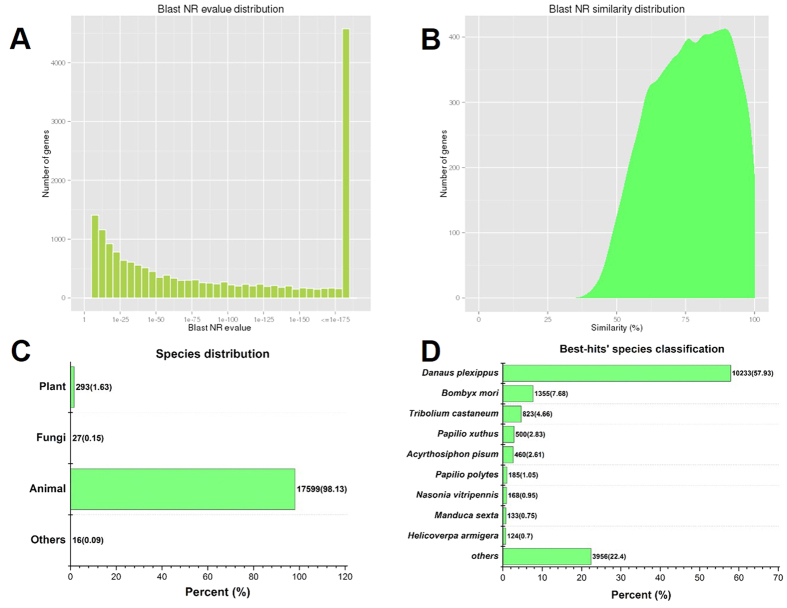
Characteristics of similarity search against Nr databases.(A) E-value distribution of BLAST hits for unigenes with a cutoff E-value of 1.0E–5. (B) Similarity distribution of the top BLAST hits for unigenes. (C,D) Organism species distribution of the top BLAST hits for unigenes in Nr database. The numbers of unigenes are indicated together with percentages placed in parentheses.